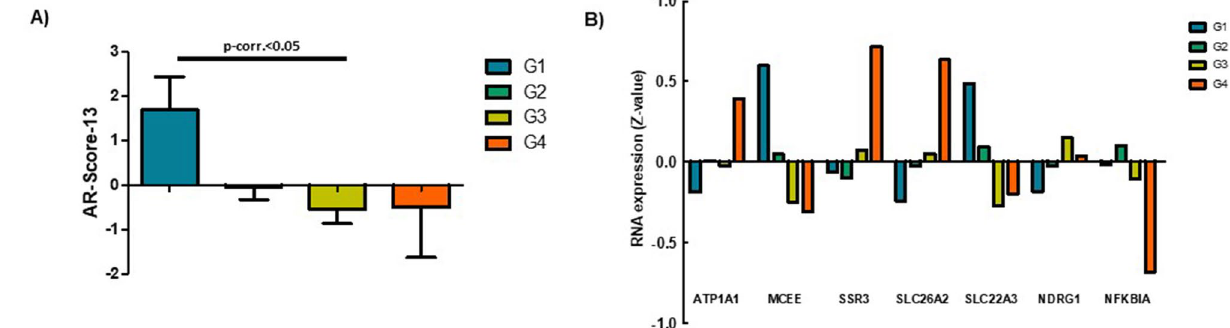
Figure 5. ( A ) AR-Score-13 in each histological grade. Significant differences between Grade I and Grade III were identified. Bars represent the mean of AR-Score-13 values, and whiskers the standard deviation in each histological grade. ( B ) Expression profile of the genes that show differences among histological grades. Bars represet the mean normalized expression of the indicated genes in each histological grade.